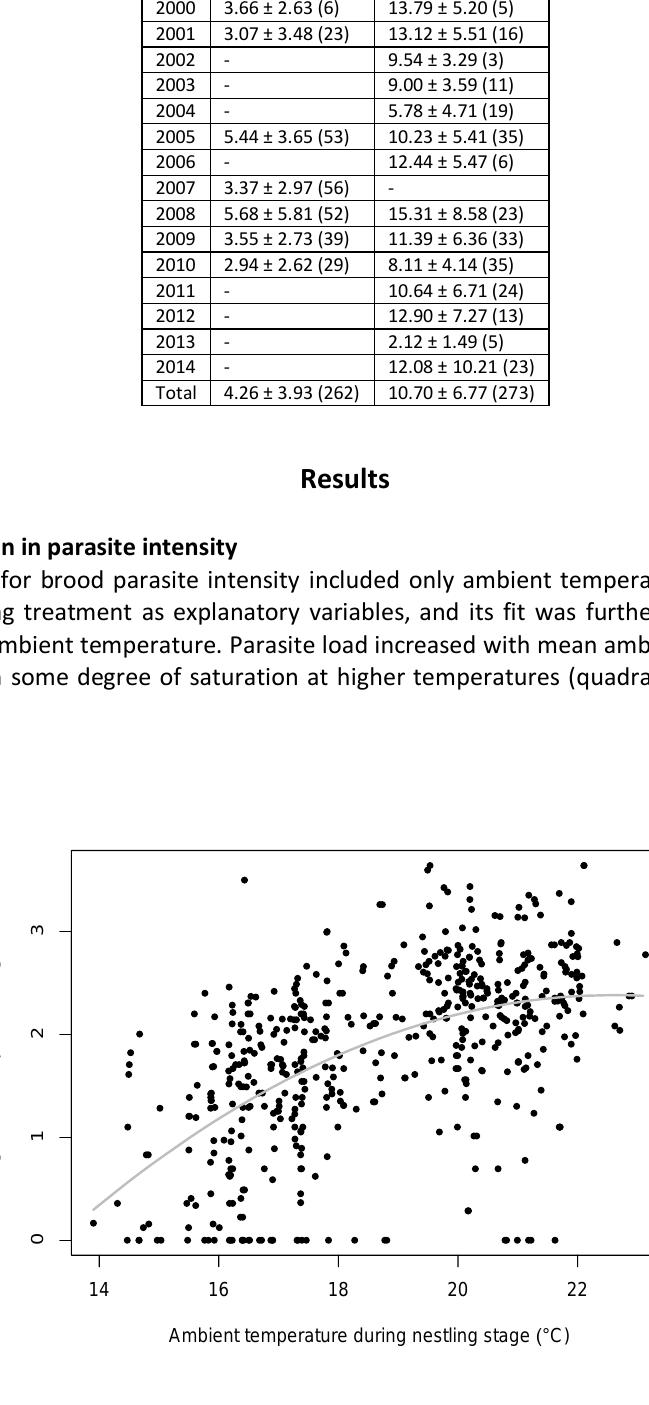
Figure 1. Across broods, parasite load increases with mean ambient temperature during the nestling stage ( i.e. during the developmental period of Protocalliphora larvae) in nests of blue tits on Corsica. Each dot represents a brood. The grey curve shows predicted values from the final model (see Table